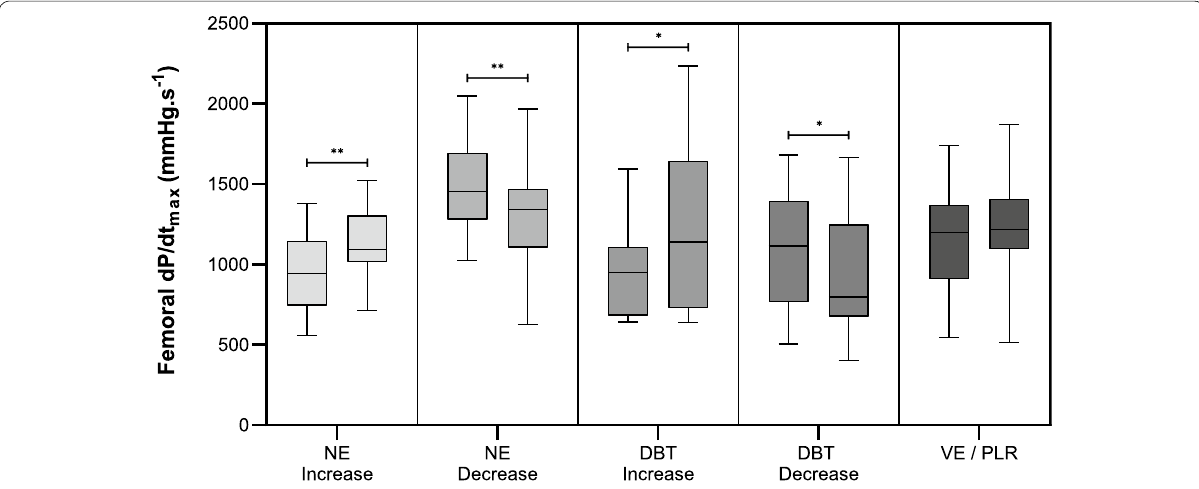
Fig. 1 Changes in femoral d P /d t max . Femoral d P /d t max before and after clinical interventions. Skewers indicate minimum and maximum value. NE norepinephrine, DBT dobutamine, VE/PLR volume expansion, passive leg raising. * p < 0.05; ** p < 0.01